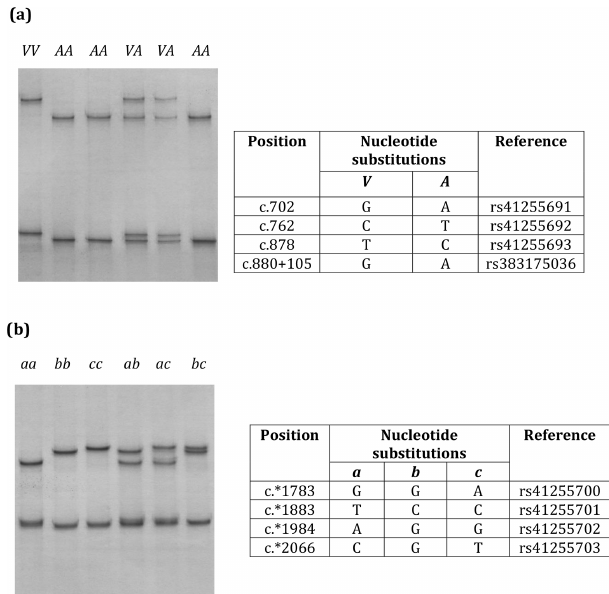
Figure 1. Variation in bovine SCD . Unique PCR-SSCP patterns representing different sequence variants of Region 1 (a) and Re- gion 2 (b) are